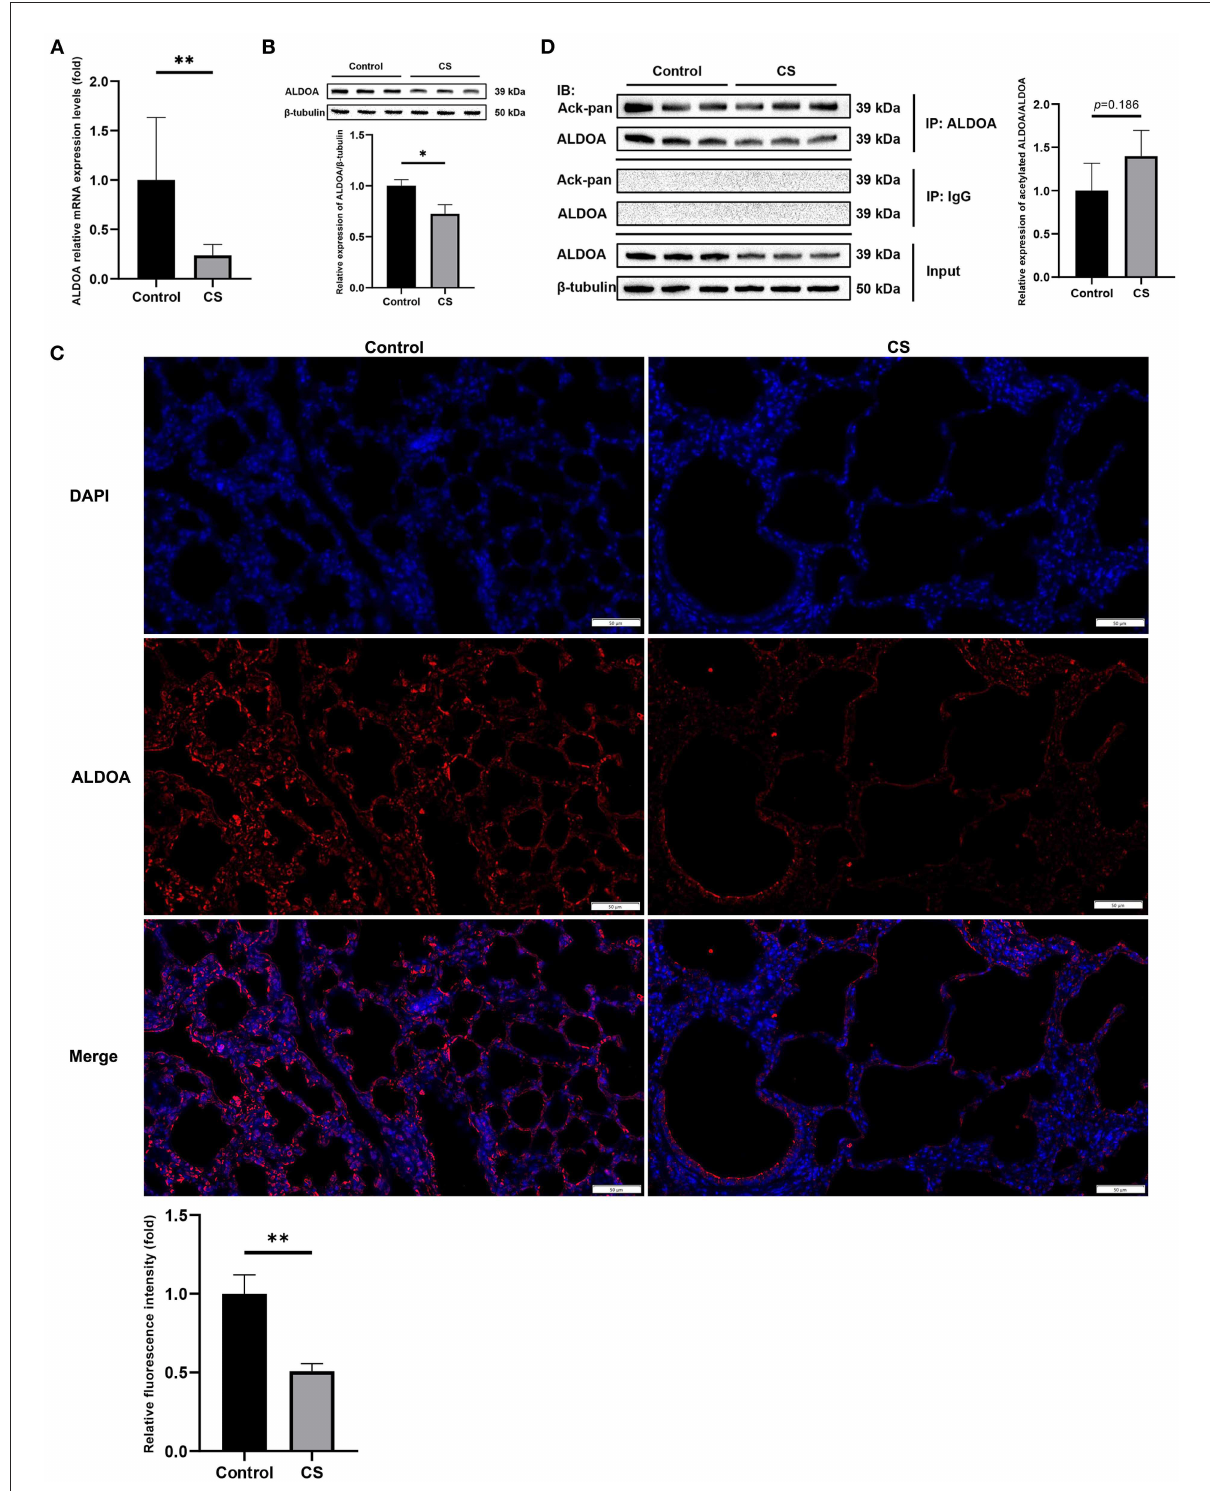
FIGURE7 In vivo experimental verification of ALDOA . (A) The mRNA level of ALDOA in COPD mice lung tissue determined by qRT-PCR. (B) The protein expression level of ALDOA in lung tissue of mice with COPD determined and quantified by Western blot analysis. (C) IF staining of lung of COPD mice at 200 × magnification, and the density quantified with Image J. (D) The acetylation level of ALDOA in lung tissue of mice with COPD determined and quantified by IP. * P < 0.05, ** P <